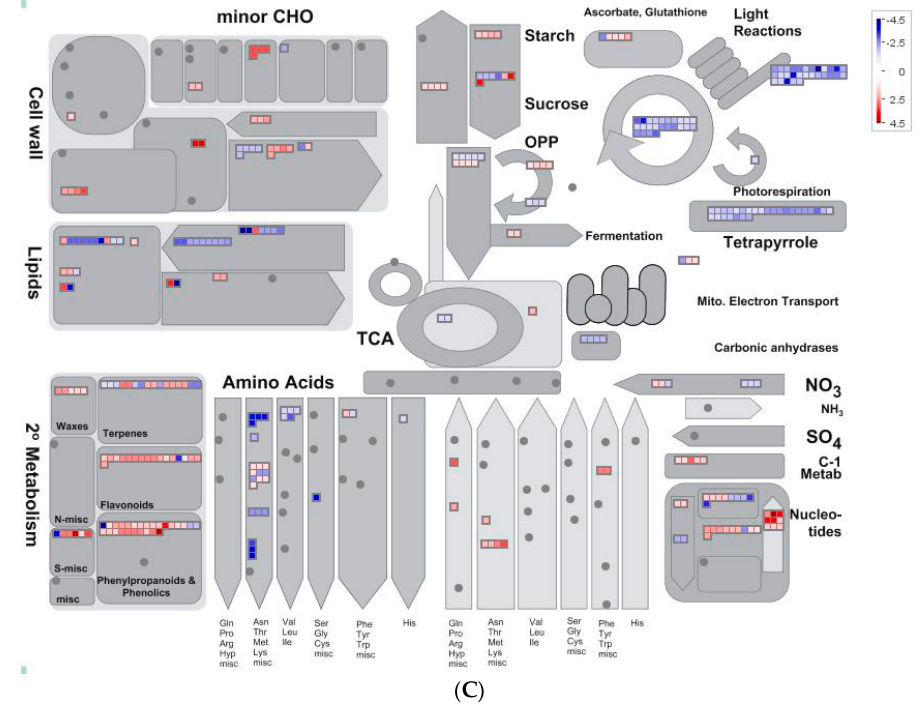
Figure 6. Overview of differentially expressed genes involved in various metabolic processes under different treatments. ( A ) Q vs. control; ( B ) Q + SA vs. Q; and ( C ) Q + SA vs. control. The images were obtained using MapMan, showing different functional categories that passed the cutoff (less than 0.05 q value and greater than two-fold change) for differential expression. The red color represents up-regulated genes, and the blue color represents down-regulated genes.